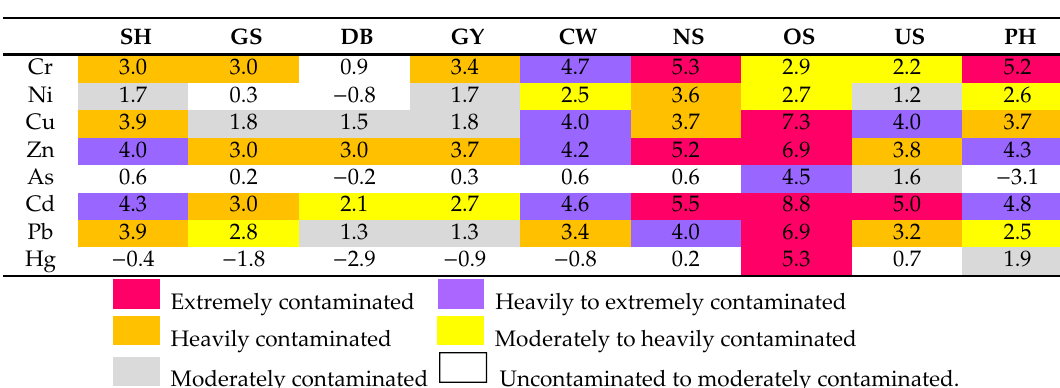
Table 4. Comparison of median I geo values in RD from 9 di ff erent industrial areas of Korea.